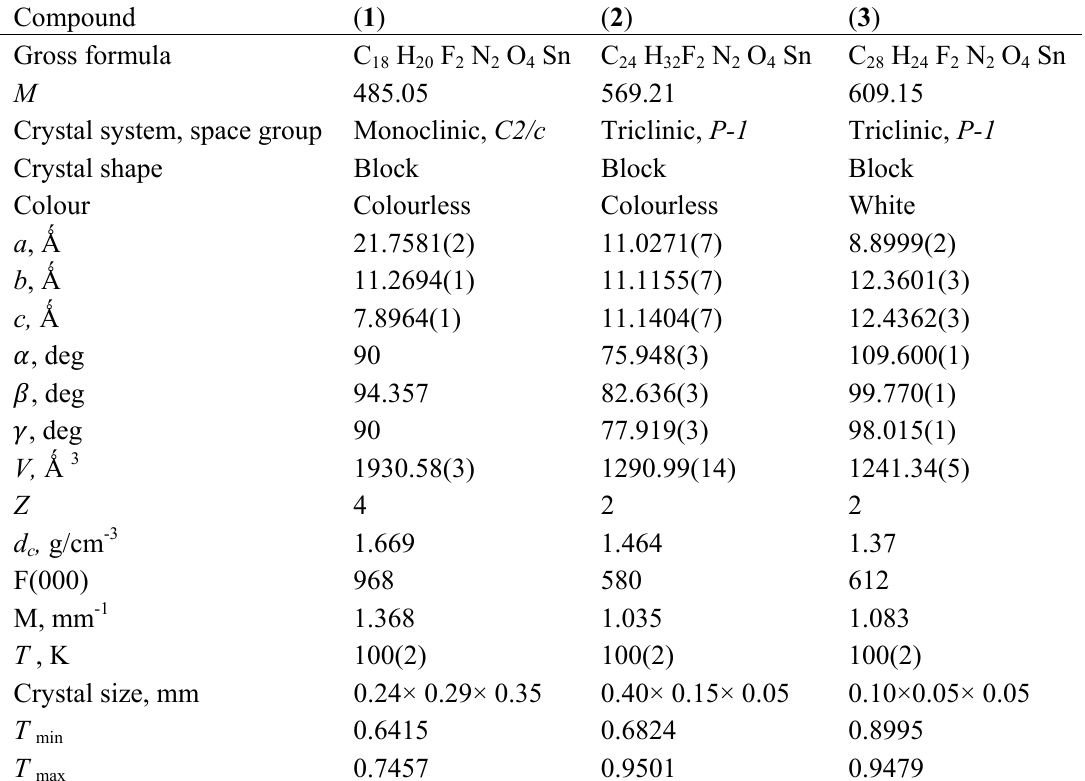
Table 4. Crystallographic parameter for the diorganotin compounds ( 1 ), ( 2 ) and ( 3 ).